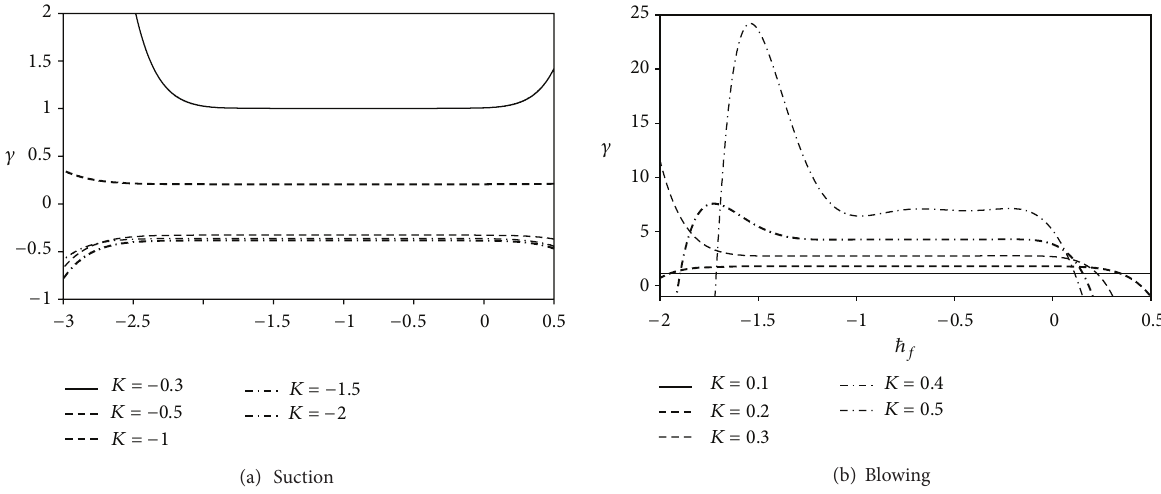
Figure 1: The ℎ 𝑓 curve of 𝛾 = 𝛽 2 using 10th-order HAM approximation for the cases 𝑆 = 0.8 and Pr = 1